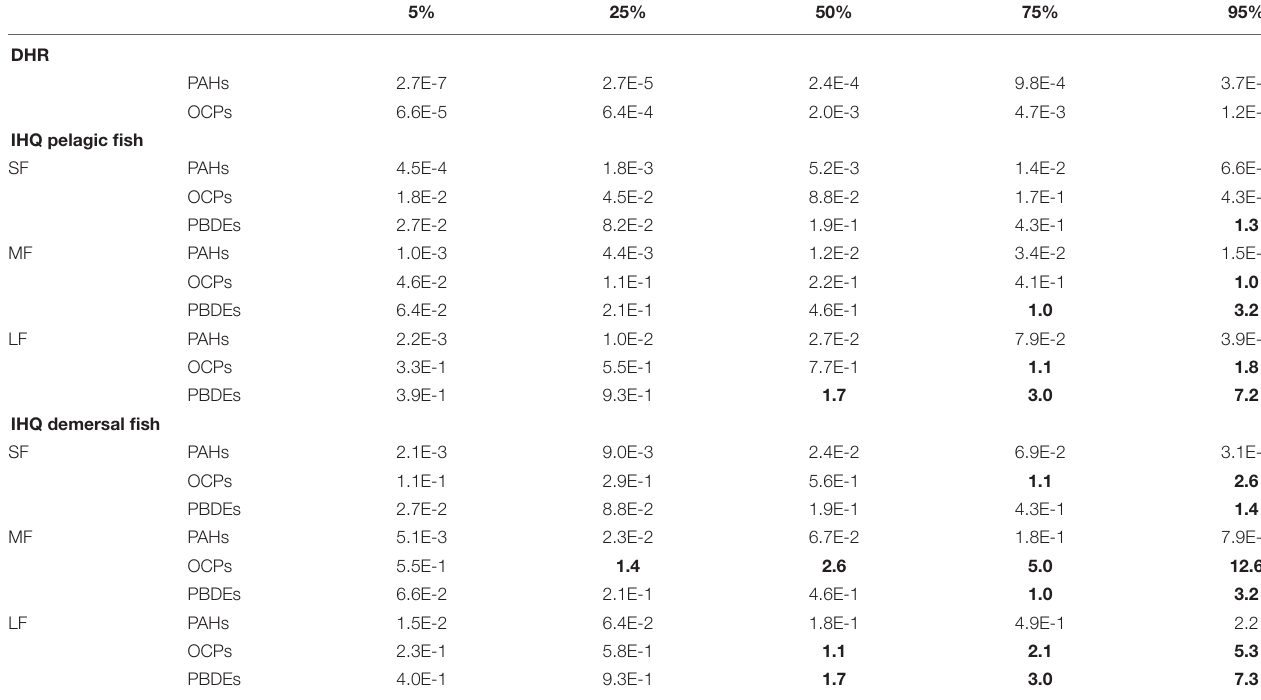
TABLE 8 | Monte Carlo simulation, probabilistic distribution of DHR and IHR, statistical values